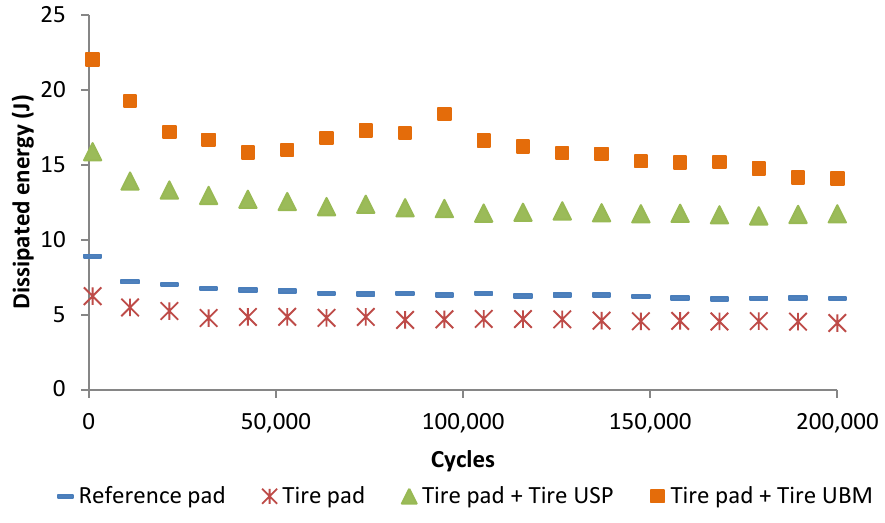
Figure 10. Effect of tire elements in the capacity of the ballasted system to dissipate